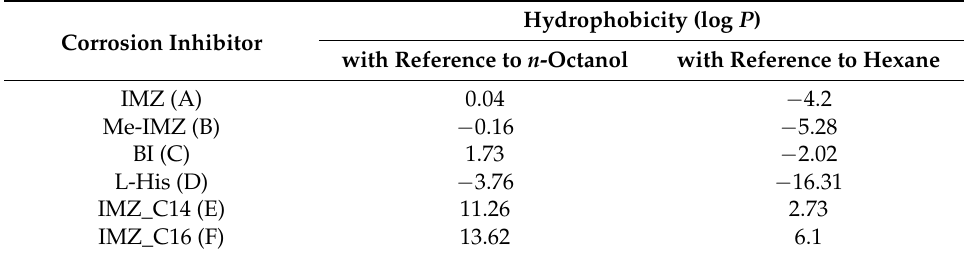
Table 3. Calculated values of log P using free energy of solvation.